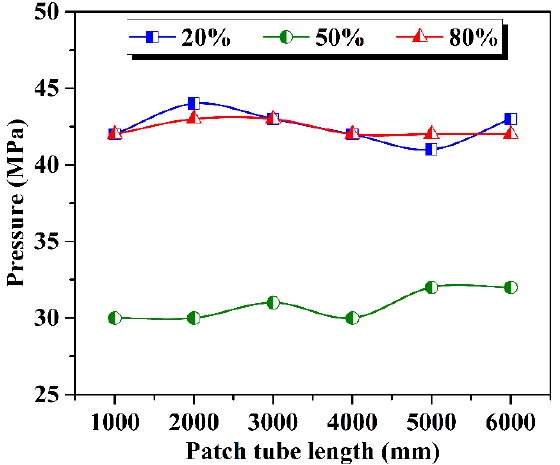
Figure 9. Forming limit diagrams of patch tube with different lengths.